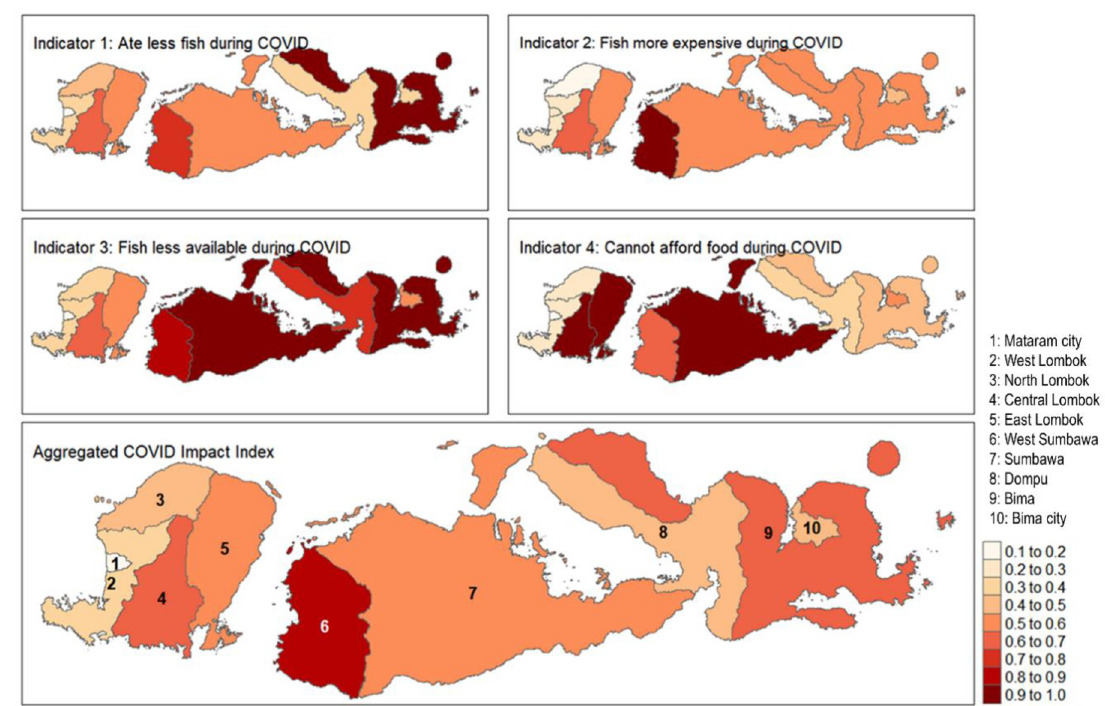
Fig 5. COVID seafood consumption impact index scores by regency/ kota . Four (of seven total) indicators along with aggregated index score.